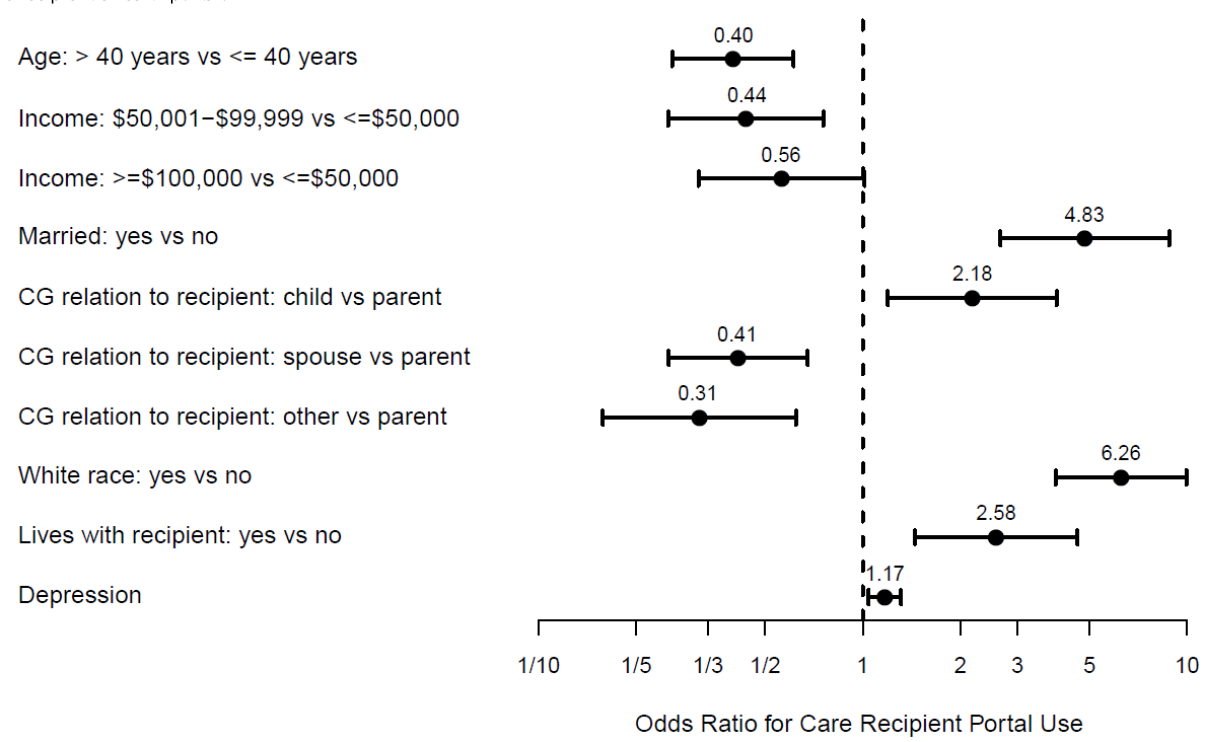
Figure 4. Multivariate odds ratios (dots) and 95% confidence intervals (bars) for combined caregiver characteristics and mental health for the use of a care recipient’s health